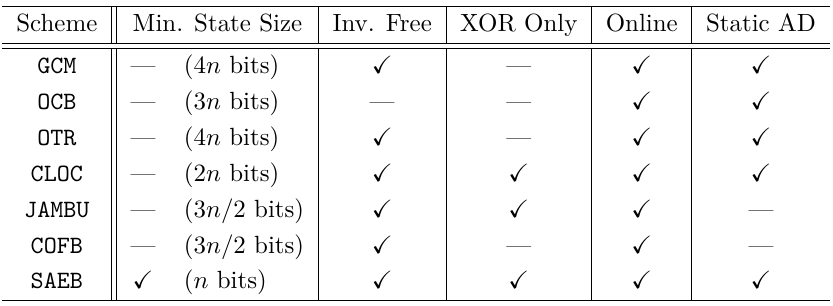
Table 1: Comparison between SAEB and existing AEAD modes of operation GCM [MV04], OCB [KR11, Rog04, RBBK01], OTR [Min14], CLOC [IMGM14], JAMBU [WH] and COFB [CIMN17] with respect to the properties 1-5. “ (cid:88) ” (resp., “—”) means that